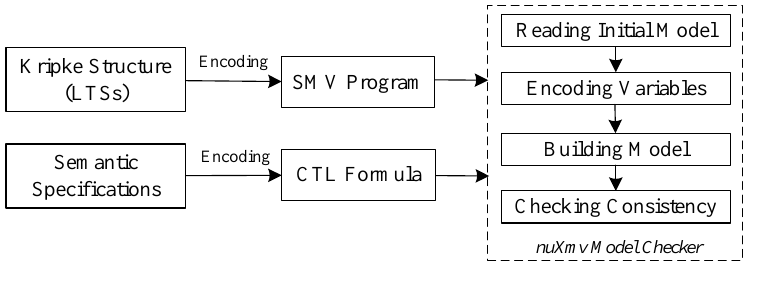
Figure 6. The main steps of the